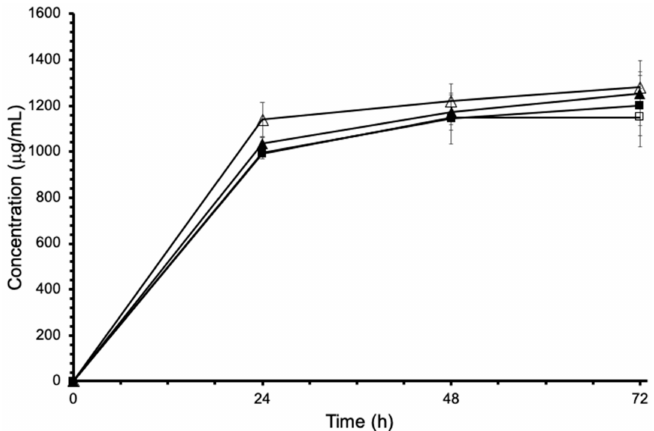
Figure 8. Equilibrium solubility at 37 ◦ C of Tax-ET in pH 1.2 ( (cid:4) ) and pH 4.5 ( (cid:78) ) solutions and Tax-EA in pH 1.2 ( (cid:3) ) and pH 4.5 ( (cid:97) ) solutions. The scale bars correspond to the standard deviation values; experiments were performed in